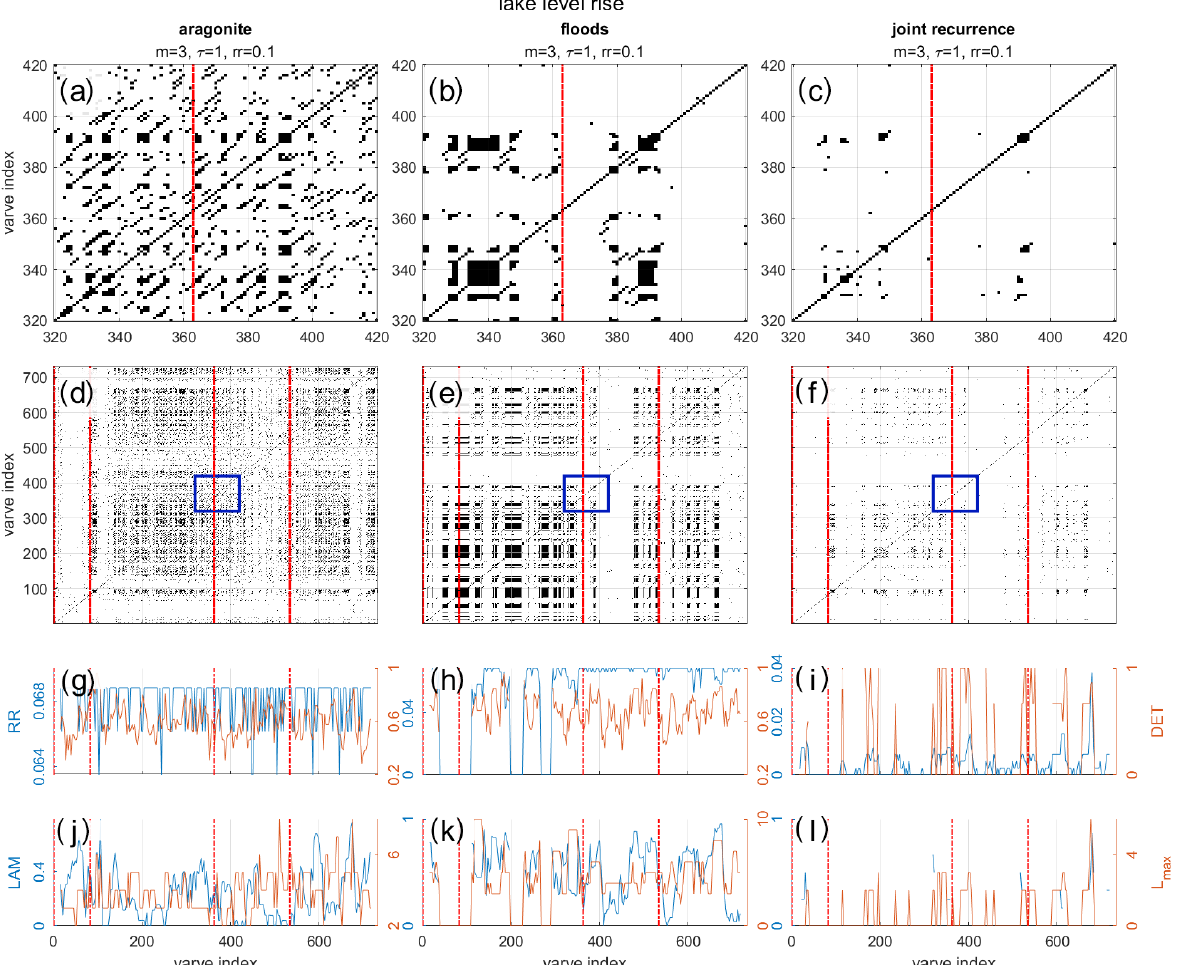
Figure 7. (a–c) Enlarged segments of the recurrence plots of the studied lake-level rise for aragonite thickness (a) , flood frequency (b) , and the joint recurrence plot for the two proxies (c) . (d–f) Recurrence plots of the aragonite thickness (d) and flood frequency (e) and the joint recurrence plot for the two proxies (f) , with blue rectangles indicating the extent of data presented in (a) – (c) . Note the parallel diagonal lines that characterize the series of aragonite thickness (a, d) and point to an inherent oscillatory behaviour, whereas the flood series (b, e) forms sporadic points and polygons that reflect a more chaotic or random behaviour. (g–i) The recurrence rate (RR) and the determinism (DET) coefficient calculated using a running window size of 30 years and a single-year step for aragonite thickness (g) , floods (h) , and their joint recurrence (i) . (j–l) The laminarity (LAM) and the maximum length of the diagonal line within the sub-matrix ( L max ) coefficient using a running window size of 30 years and a single-year step for aragonite thickness (j) , floods (k) , and their joint recurrence (l) . The analyses were performed after detrending the data by subtracting the RC (1) of the SSA and normalizing to zero mean and unit standard deviation. The selected parameters for the embedding are m (dimension), τ (delay) and ε (threshold) used for space phase reconstructions and depicted in the figure. Red lines represent possible clusters identified independently of the recurrence